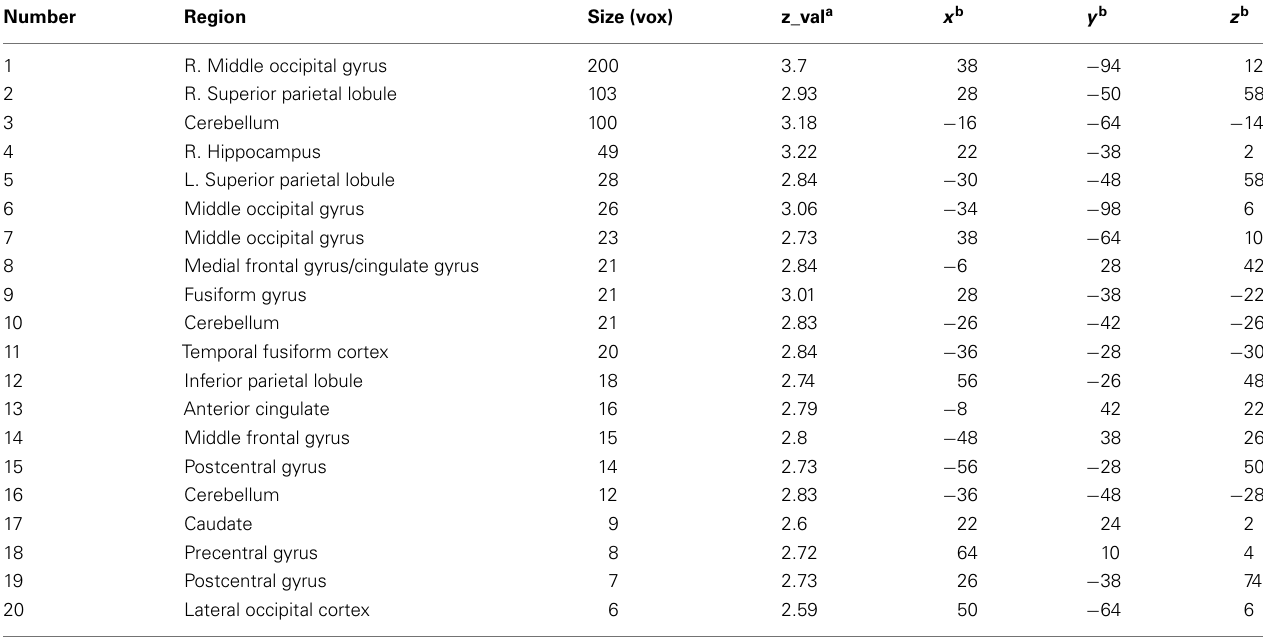
TableA1 | Uncorrected regions of activation from the quadratic contrast showing adolescent peaks. Number